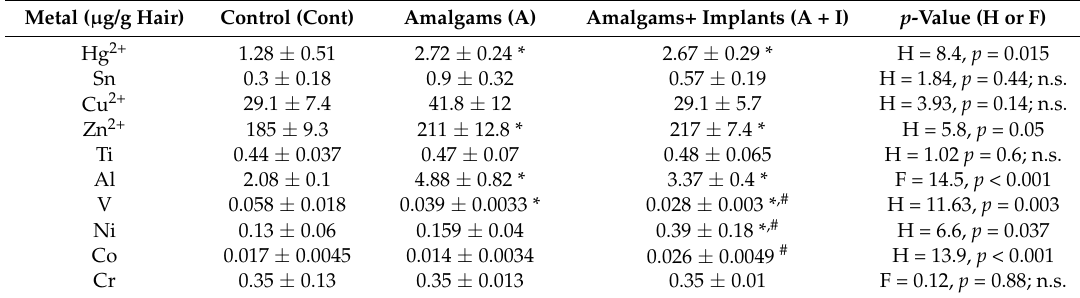
Table 1. Levels of heavy metals from amalgams (A), titanium dental implants and crowns (cobalt (Co), nickel (Ni) and chromium.